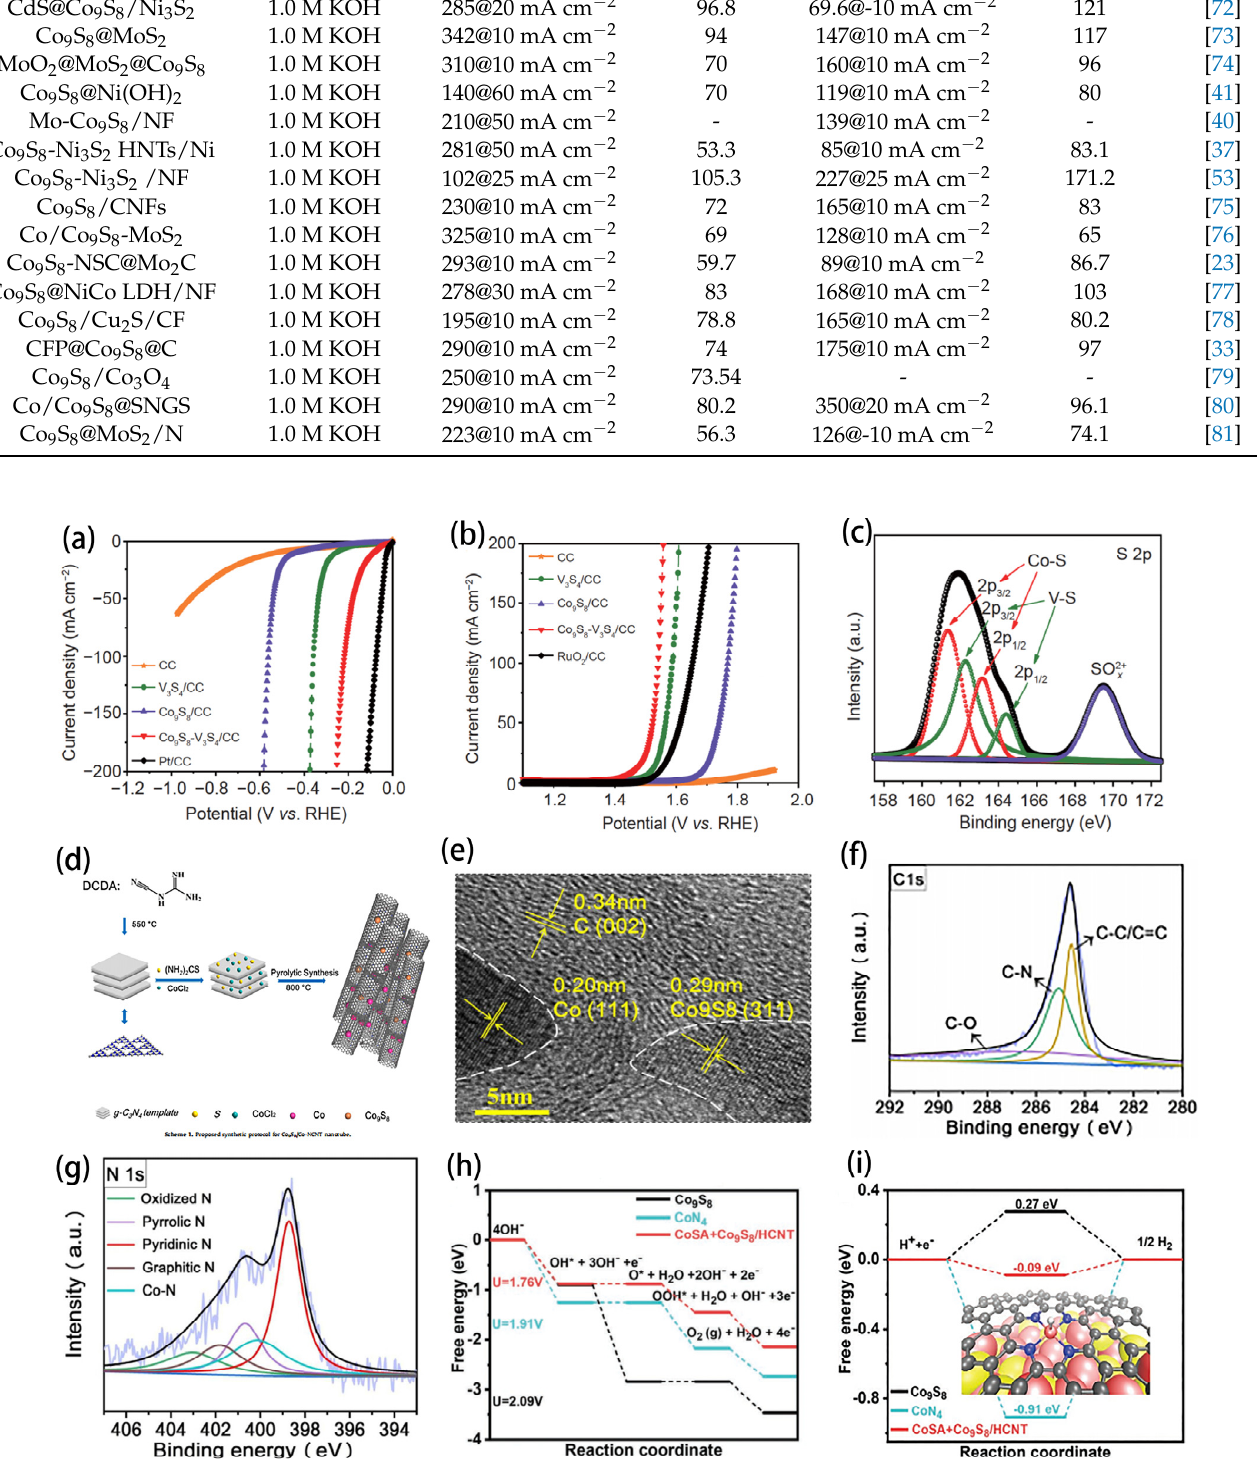
Figure 7. ( a ) Polarization curves of bare CC, V 3 S 4 /CC, Co 9 S 8 /CC, Co 9 S 8 -V 3 S 4 /CC and Pt-C/CC catalysts with a scan rate of 2 mV s − 1 in 1.0 mol L − 1 KOH for HER. ( b ) Polarization curves of bare CC, V 3 S 4 /CC, Co 9 S 8 /CC, Co 9 S 8 -V 3 S 4 /CC and RuO 2 /CC catalysts with a scan rate of 2 mV s − 1 in 1.0 mol L − 1 KOH for OER. ( c ) XPS survey spectrum of S 2p of Co 9 S 8 -V 3 S 4 /CC. Reprinted with permission from